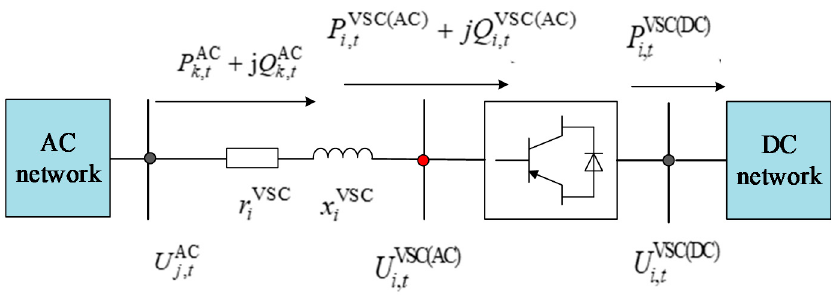
Figure 2. Schematic diagram of the voltage source converter.